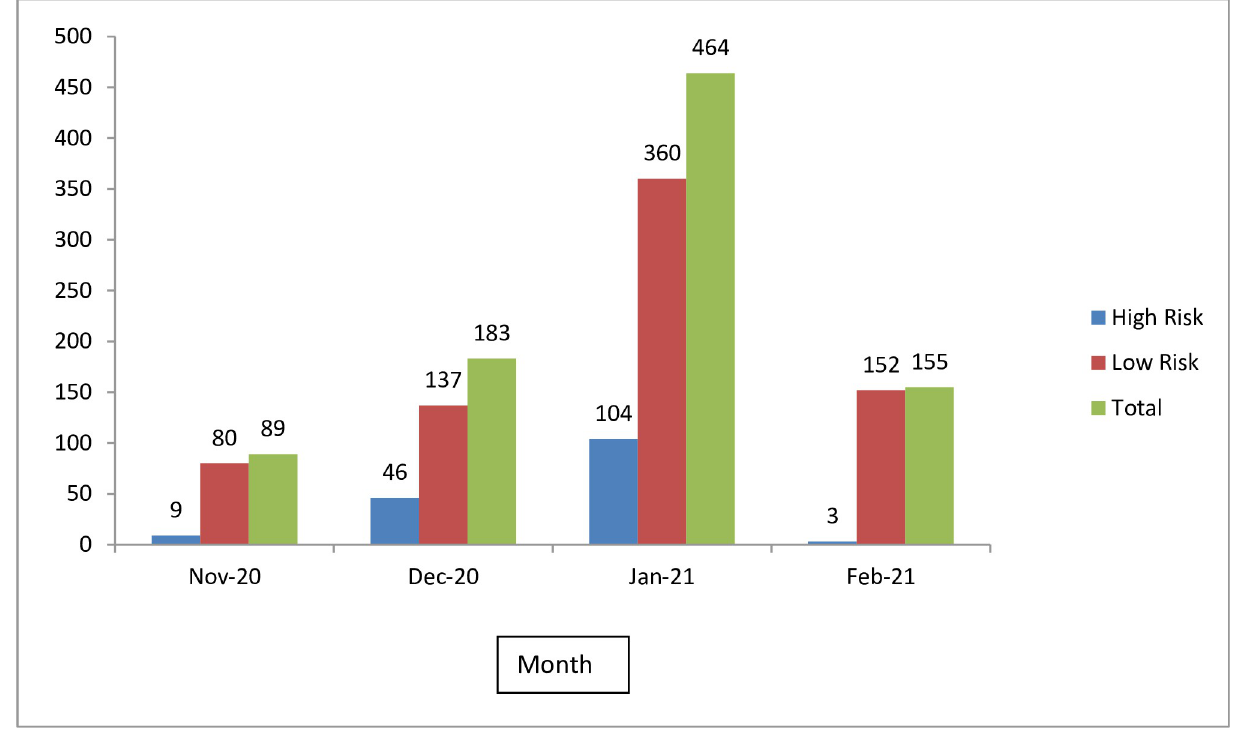
Fig 3. Number of HCWs quarantined as high risk from November 2020 to February 2021.